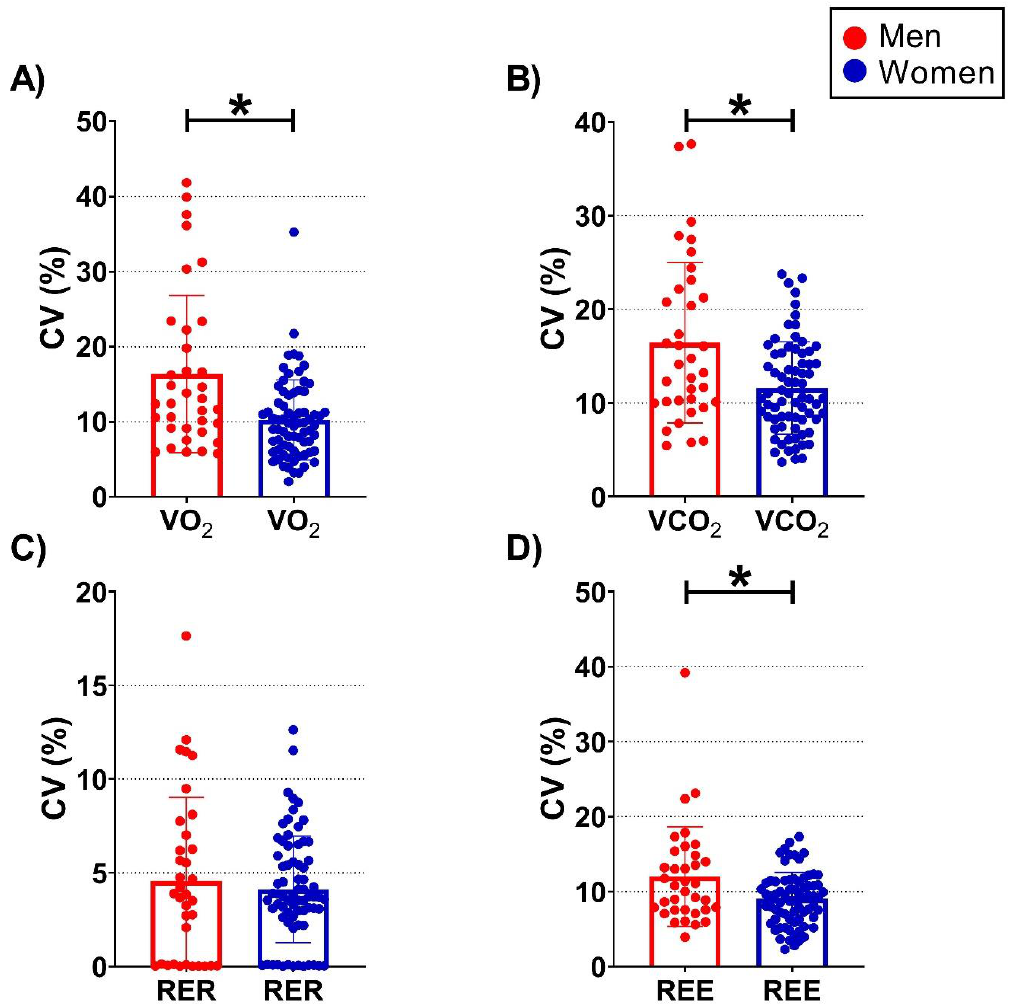
Figure 2. Column plots for each coefficient of variation (CV, expressed as a percentage) of the data separated by men (red circles) and women (blue circles). Results are presented as mean and standard deviation, and all data points (i.e., individual values). CV were calculated for each individual and parameter, i.e., for the volume of oxygen consumption (VO 2 ; Panel ( A )), for the volume of carbon dioxide production (VCO 2 ; Panel ( B )), for the respiratory exchange ratio (RER; Panel ( C )), and for the resting metabolic rate (RMR; i.e., resting energy expenditure [REE] estimated using the equation proposed by Weir [30] and assuming no urinary nitrogen excretion; Panel ( D )). * represents p -values < 0.05 derived from analysis of covariance (ANCOVA) to examine between sex (i.e., men vs. women) adjusted mean differences while taking participants’ age into account as a confounder (i.e., ANCOVA models adjusted for age). N = 35 and 72 for men and women,